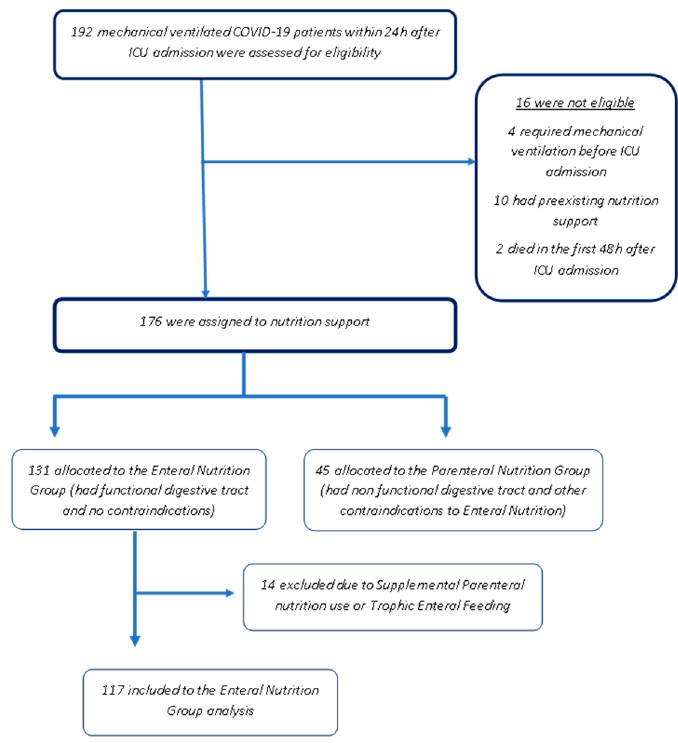
Figure 1. Patient recruitment flow chart. Table 1. Baseline characteristics of the participants ( n =